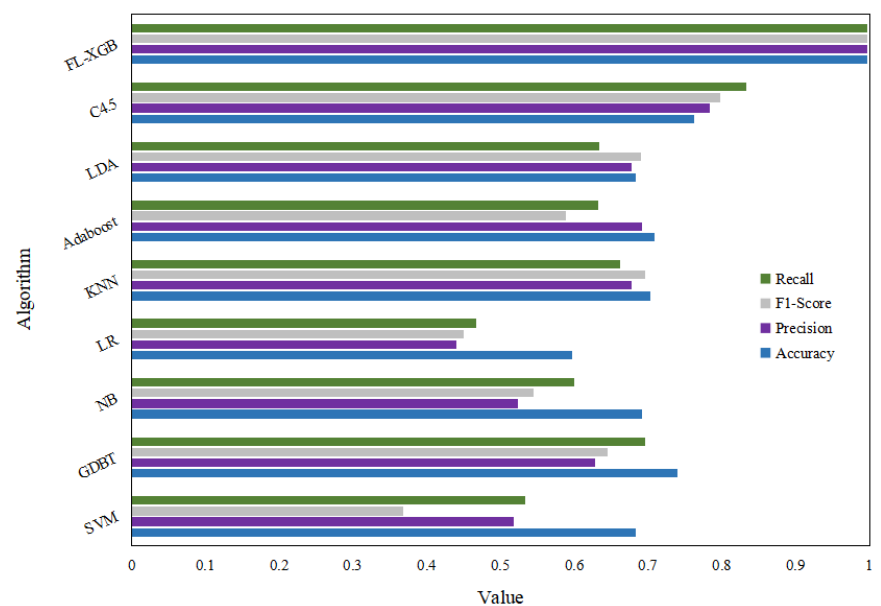
Figure 17. Comparison of different algorithms on the ISCXTor2016 dataset.